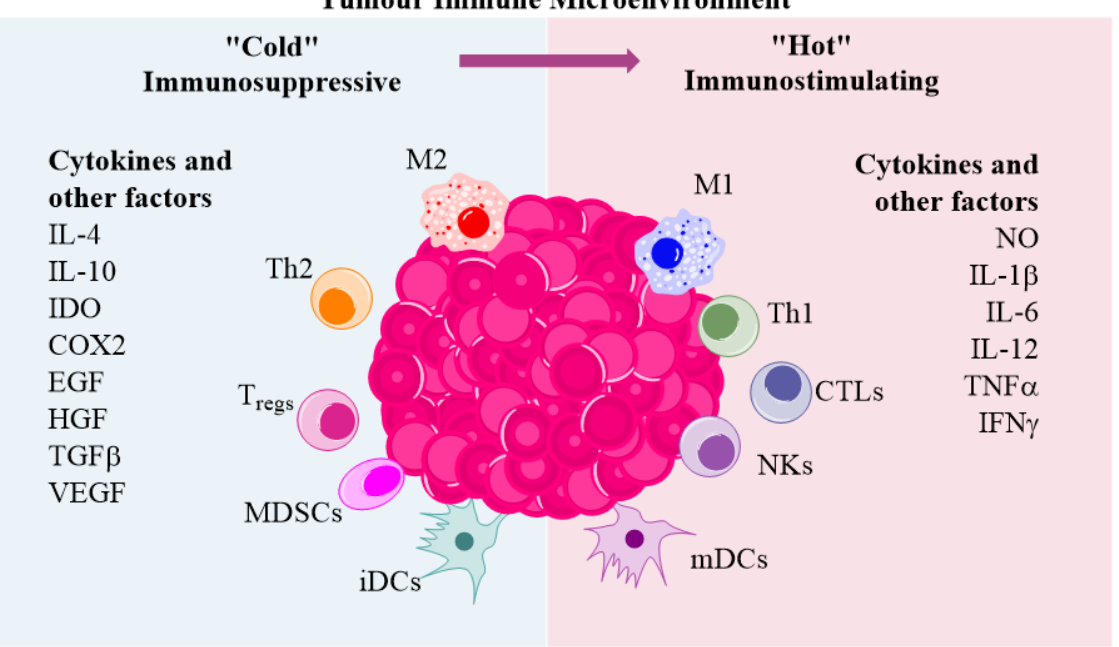
Figure 2. Composition of the “Cold” immunosuppressive tumour microenvironment versus “Hot” immunostimulating tumour microenvironment (TME): immune cells, cytokines and other factors. TME reprogramming towards a “hot” state is a promising cancer therapy strategy. M1— classically activated macrophages, M2 — alternatively activated macrophages, Th1 — type I T helper cells, Th2 — type II T helper cells, Tregs — regulatory T cells, CTLs — cytotoxic T lymphocytes, NKs — natural killer cells, MDSCs — myeloid-derived suppressor cells, iDCs — immature dendritic cells, mDCs — mature dendritic cells. IDO — indoleamine-2,3-dioxygenase, COX2 — cyclooxygenase-2, NO — nitric oxide.